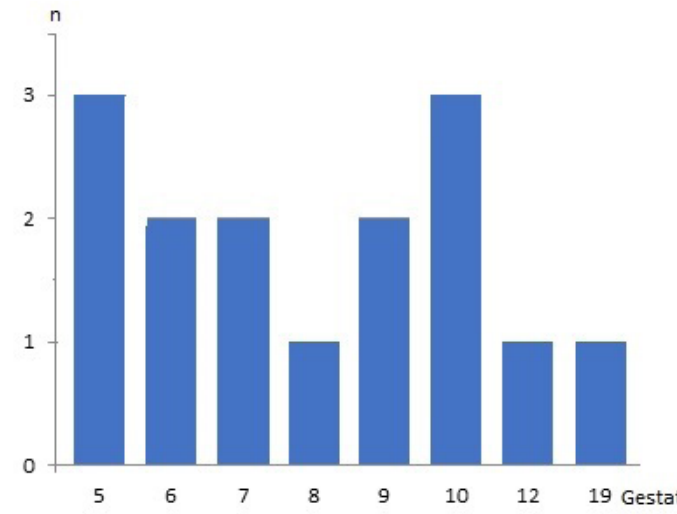
Figure 1. Number of miscarriage by gestational